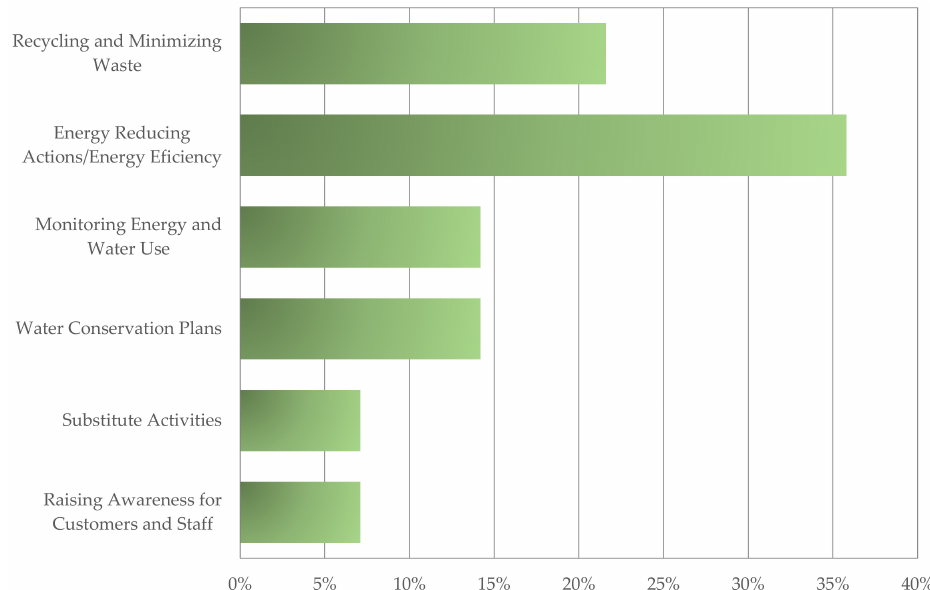
Figure 6. Respondents Perceptions: measures taken to reduce contribution to climate change (Q16).